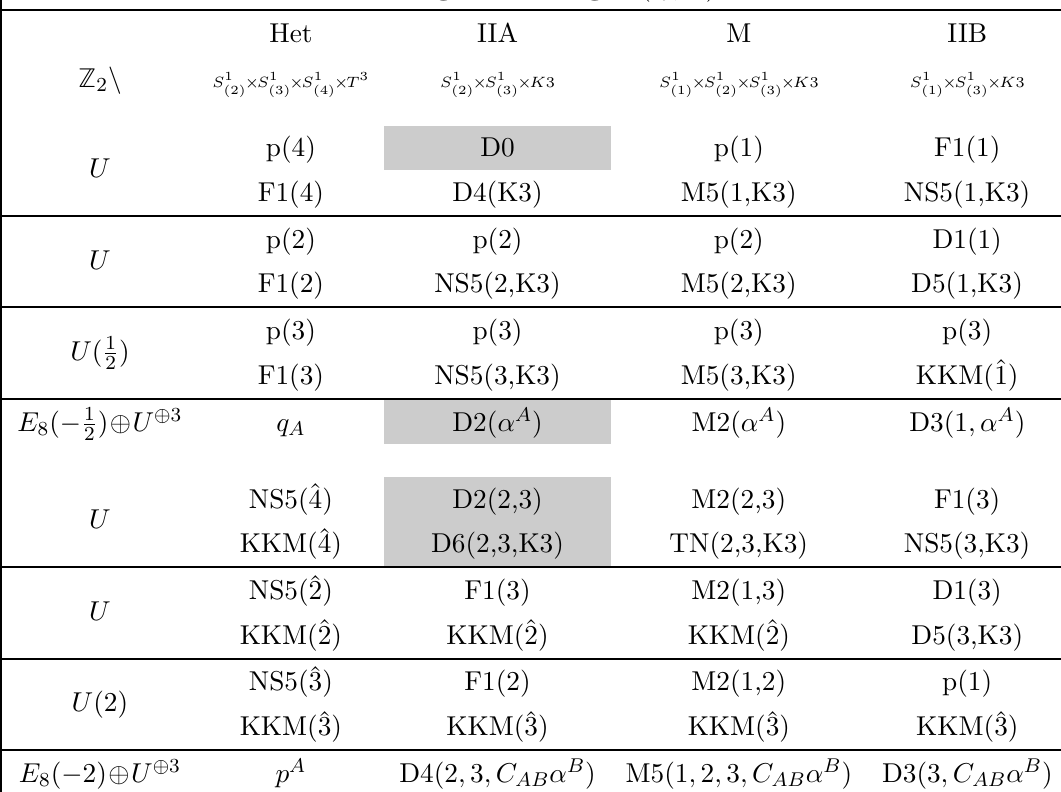
Table 2 . Sources of the dyon charge ( Q, P ) in different duality frames of the four-dimensional N = 4 Z 2 CHL model. The α A ’s are a basis of the 14-dimensional lattice E 8 ( − 2) ⊕ U ⊕ 3 ∼ = H 2 ( S, Z ) g with bilinear form denoted by C AB . (Table adapted from [136, table